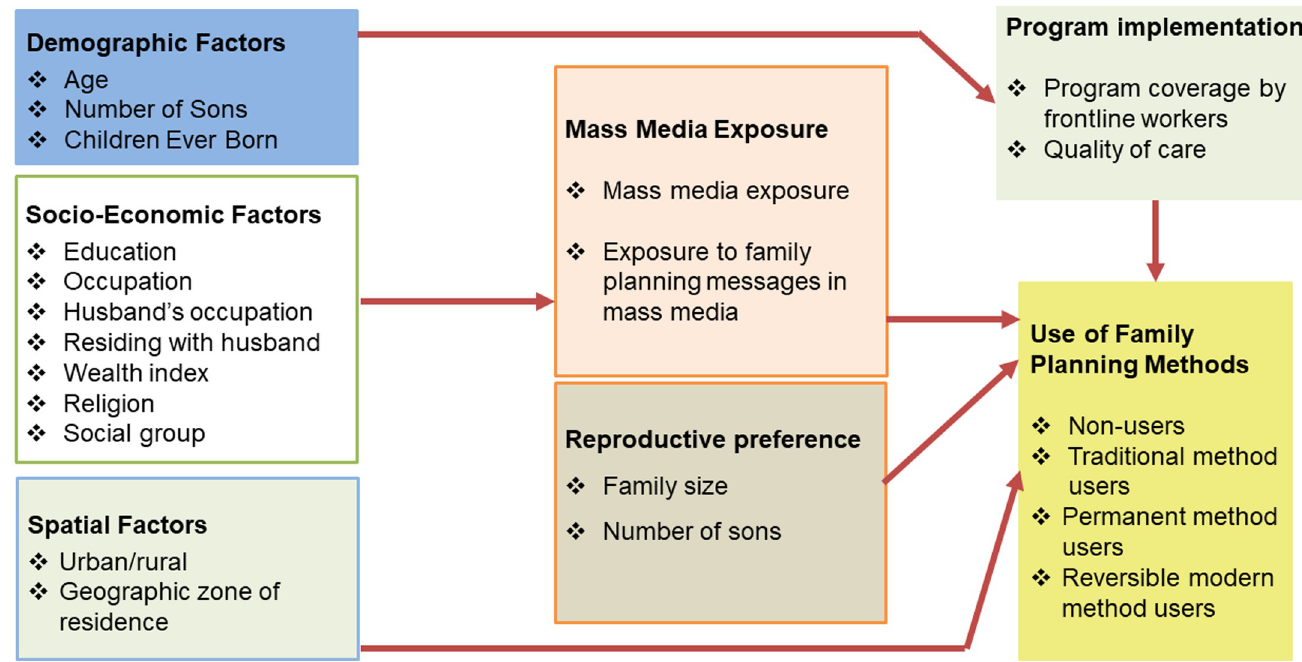
Fig 1. Conceptual framework showing the associations of mass media exposure, background characteristics of women, and other determining factors.